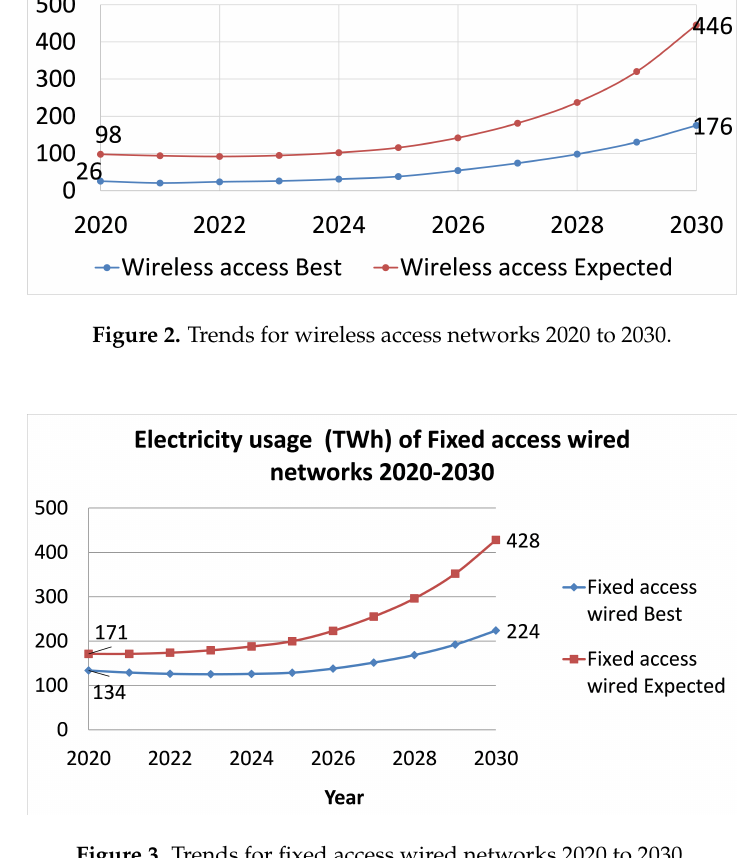
Figure 3. Trends for fixed access wired networks 2020 to 2030.